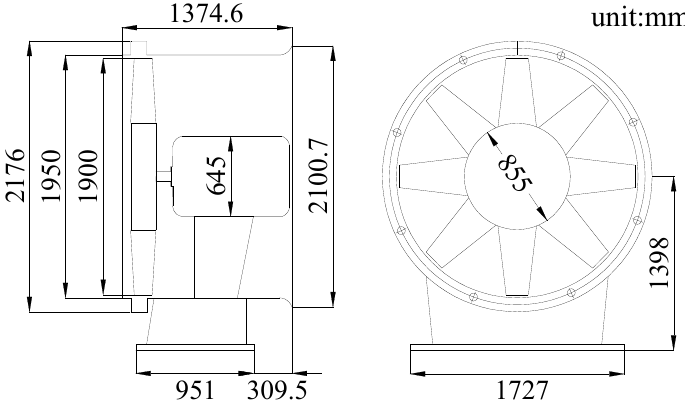
Figure 2. Structure diagram of K40(B)-19 type fan.